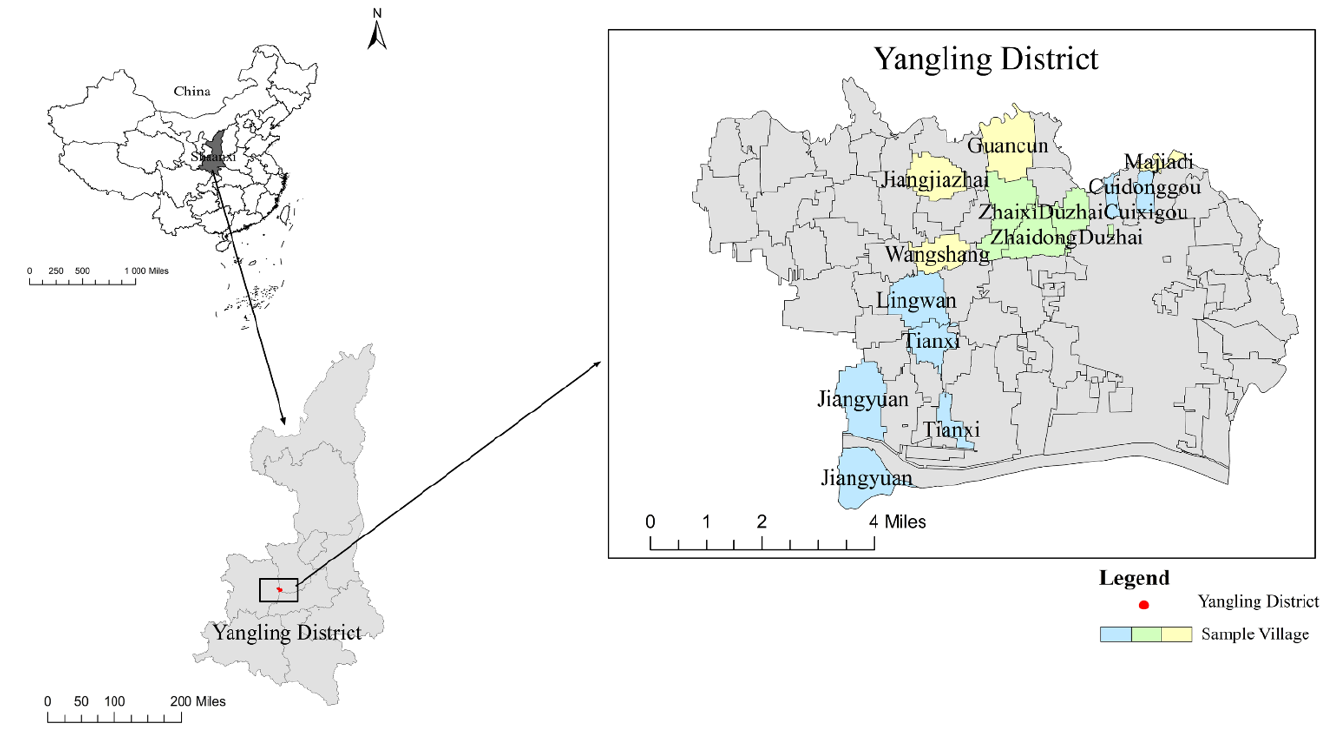
Figure 2. Study area and location of sample villages. Table 1. Questionnaire distribution and quantity.